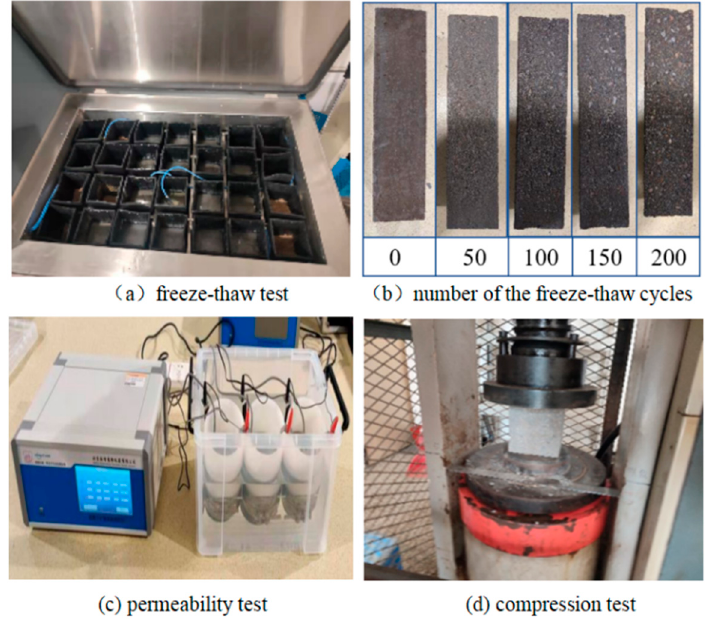
Figure 2. Procedures of the concrete deterioration tests. ( a ) freeze–thaw test; ( b ) number of the freeze–thaw cycles; ( c ) permeability test; ( d ) compression test.